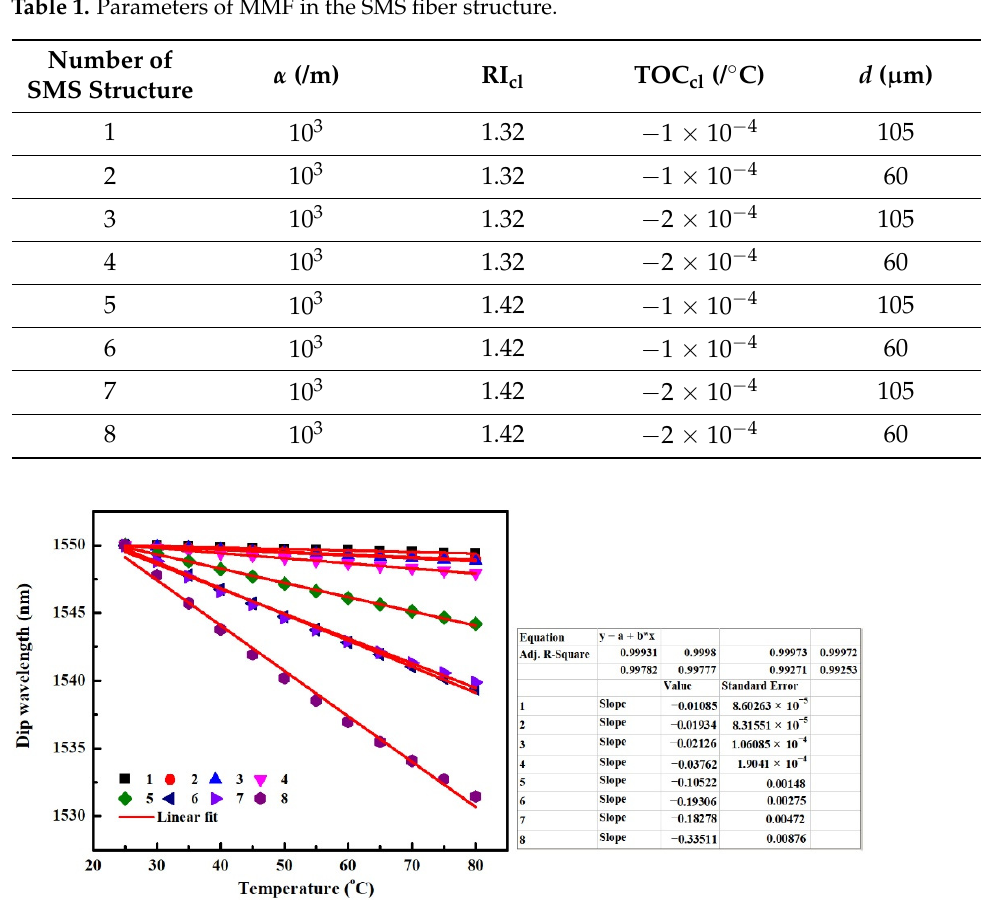
Figure 5. Dip wavelength as a function of the temperature for SMS fiber structures, only the TOE cl is taken into account in the simulation.